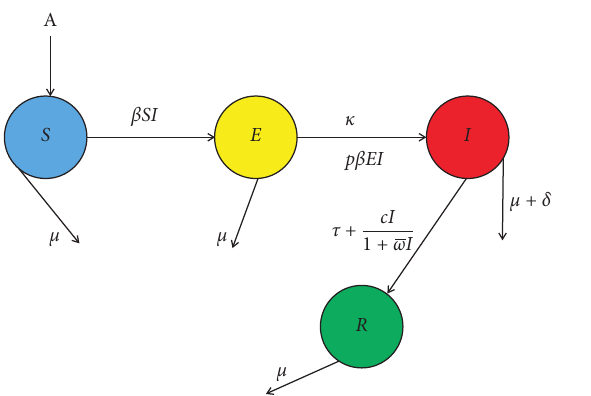
Figure 1: Schematic diagram showing the dynamics of TB in- fection with saturated